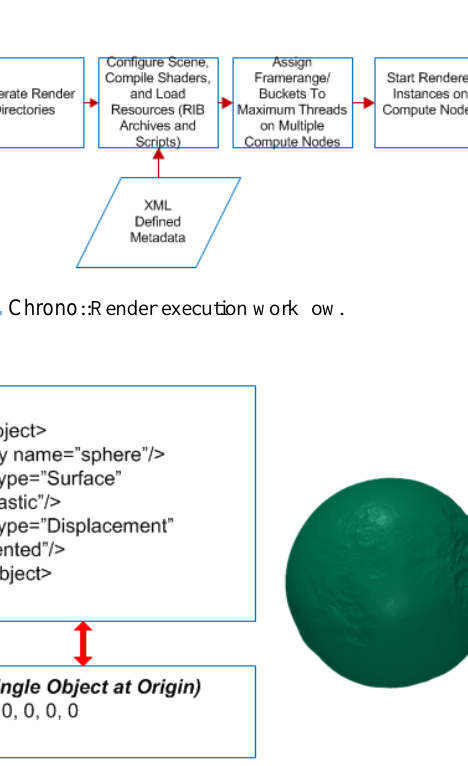
Figure 23 : Chrono ::Render execution workflow.